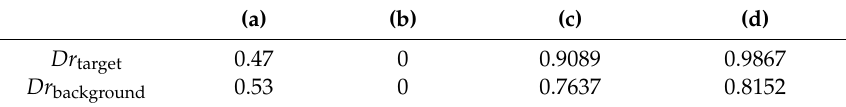
Figure 7. Detection results in different pretrain samples and training method. ( a ) SAR samples training only. ( b ) CIFAR-10 + SAR training together. ( c ) Optical Set A + SAR training apart. ( d ) CIFAR-10 + SAR training apart. Table 5. Detection results in different pretraining samples and training methods.